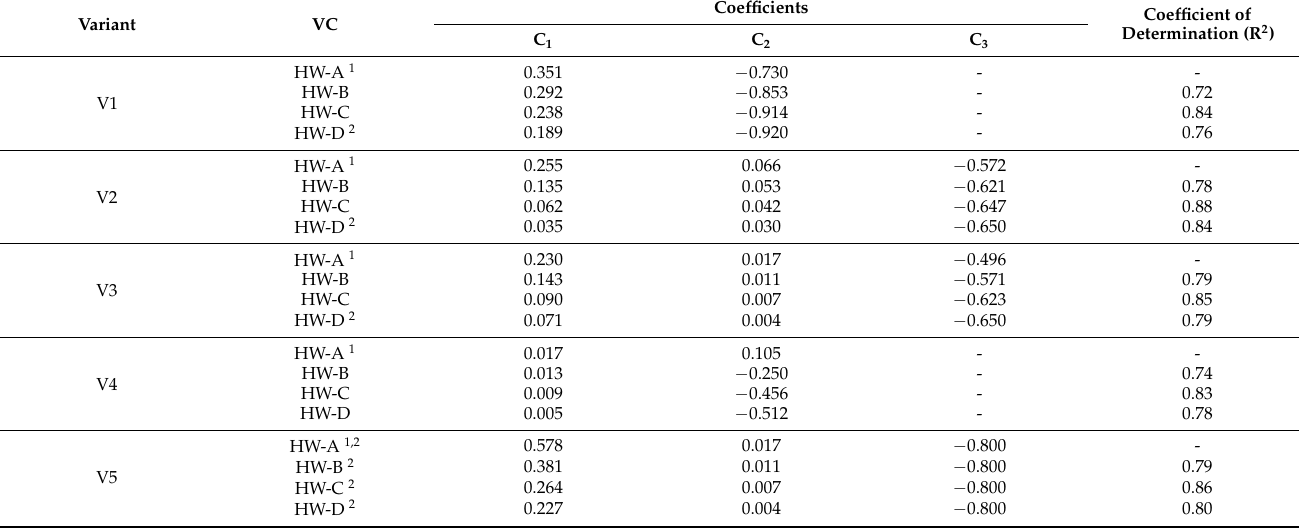
Table 5. Coefficients of the vulnerability functions D m = f(h gl ,v fl